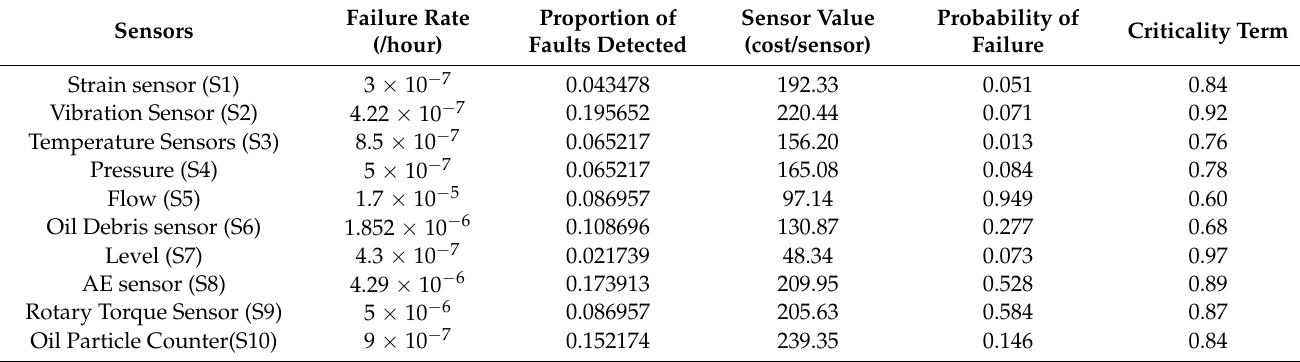
Table 4. Sensors and associated parameters for Sensor